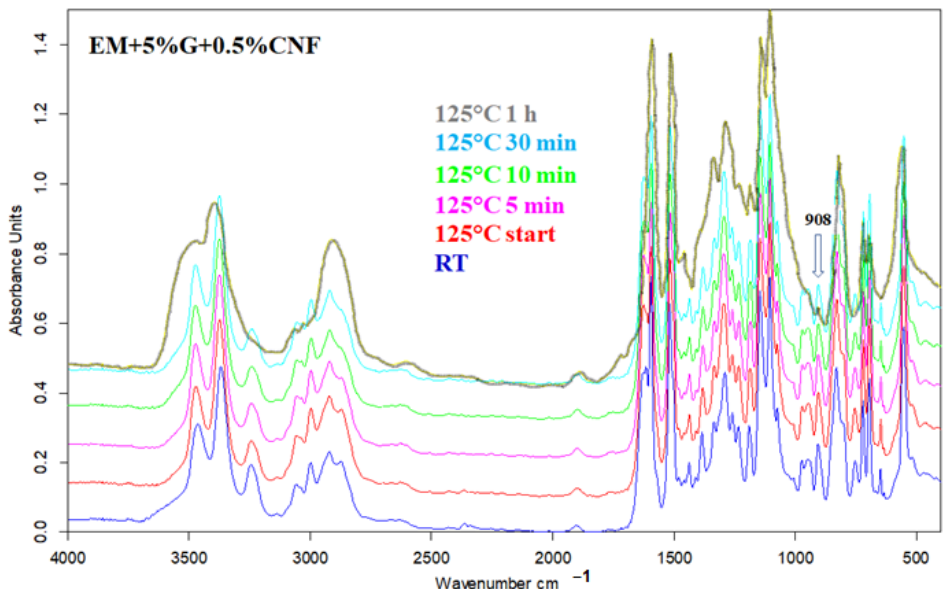
Figure 12. Spectroscopic analysis of the EM + 5%G + 0.5%CNF sample at room temperature and up to 125 °C for different times.